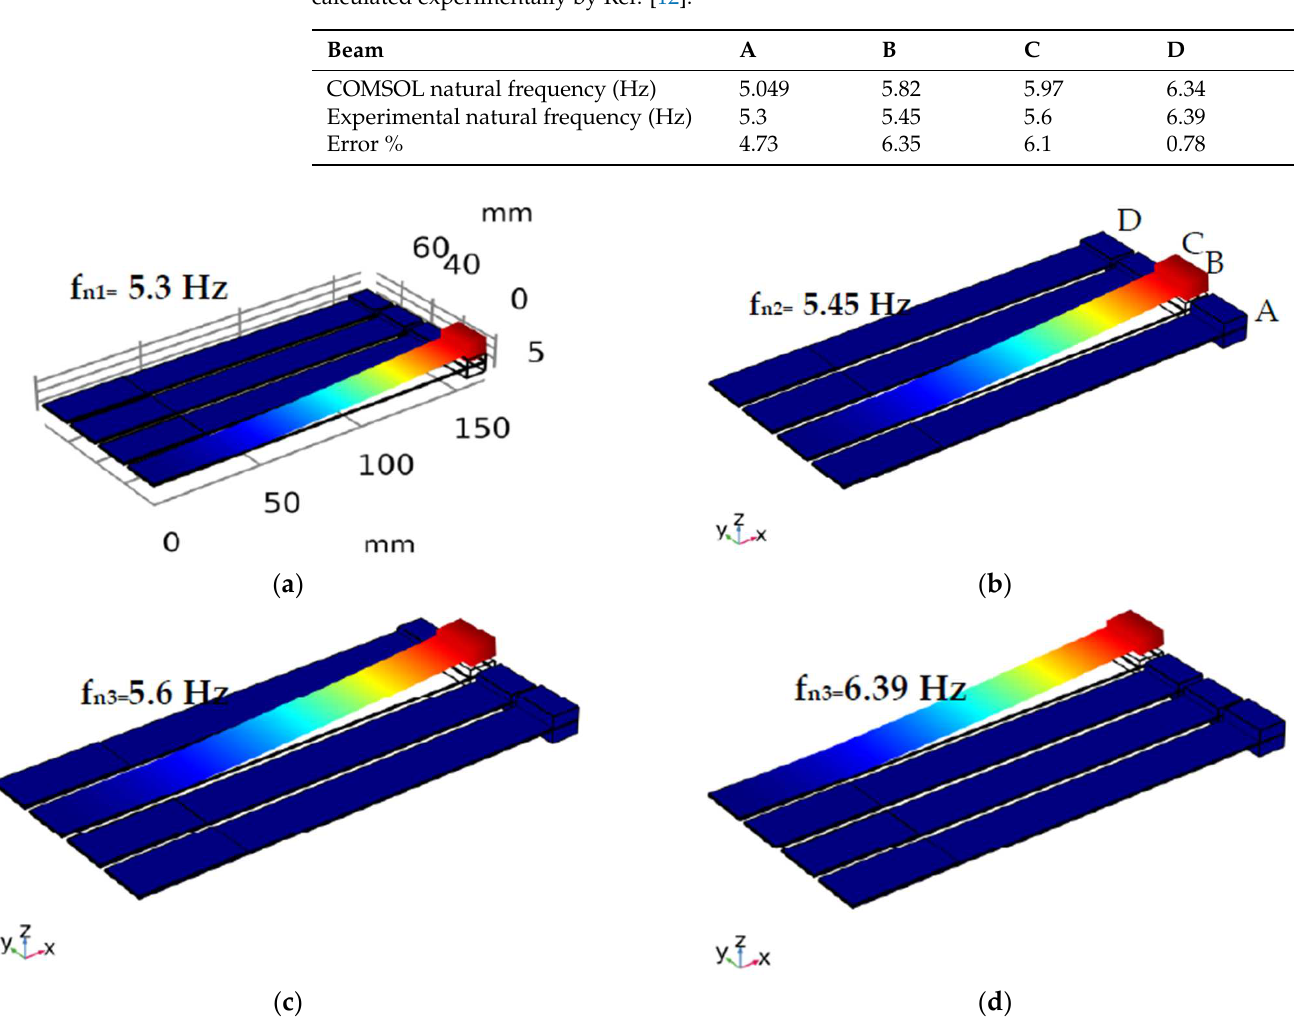
Figure 5. Natural frequencies of first array model. ( a ) natural frequency of beam A, ( b ) natural frequency of beam B, ( c ) natural frequency of beam C, and ( d ) natural frequency of beam D. Table 2. The parameters of the cantilevers utilized for validation [12].